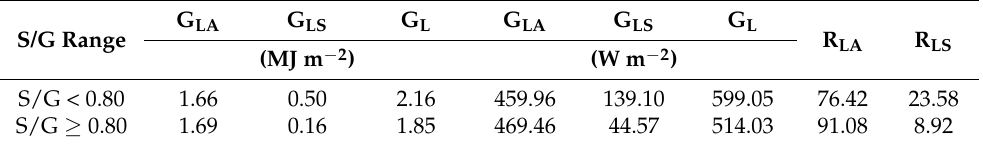
Table 5. Annual mean values of losses of global solar irradiance (MJ m − 2 ) and radiation (W m − 2 ) caused by absorbing and scattering substances (G LA and G LS ), total loss (G L = G LA + G LS ), and their contributions to total loss (R LA and R LS , %) for situations with S/G < 0.80 or S/G ≥ 0.80, respectively. Annual mean values were calculated using S/G values from observations of S and